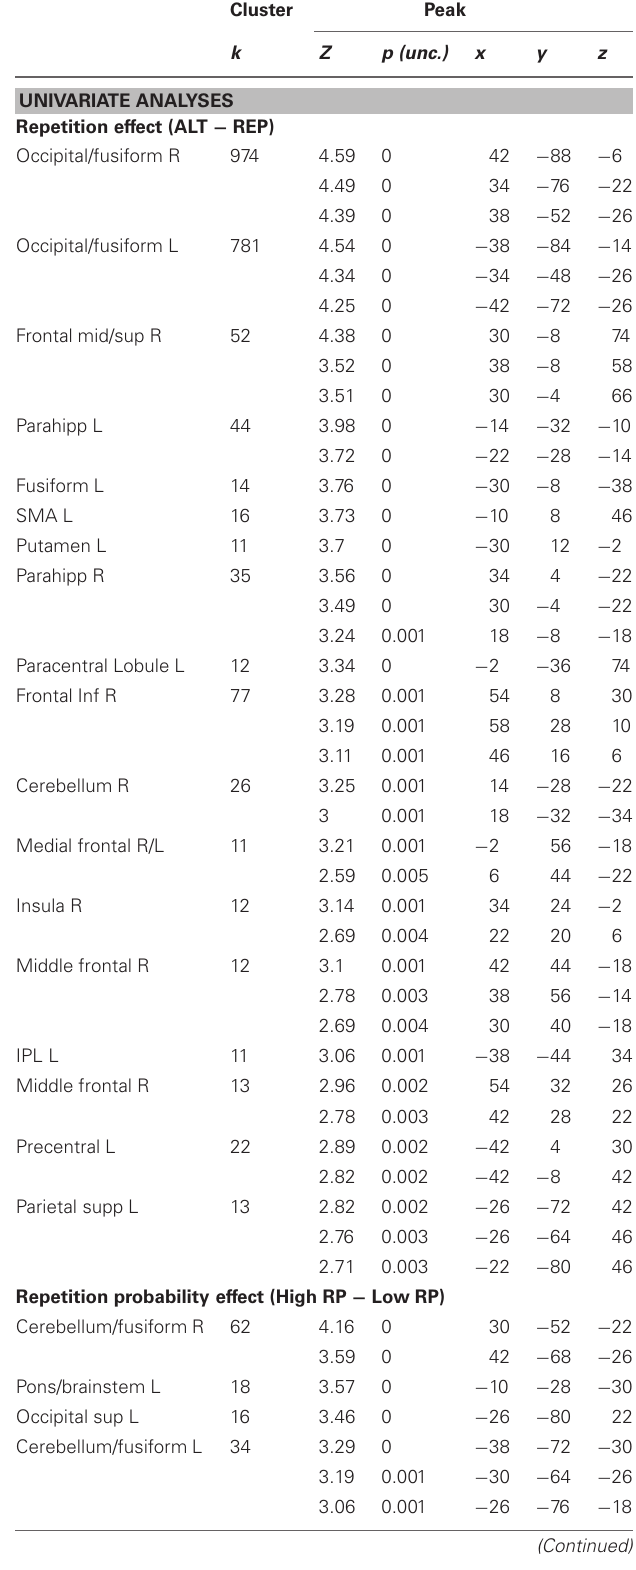
Table A2 | Whole brain results of the univariate and multivariate